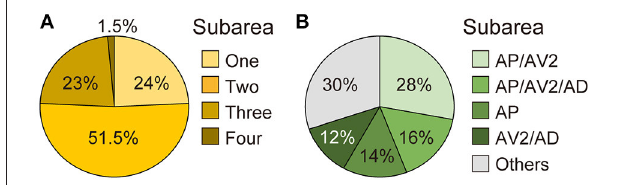
FIGURE 4 | Projection target of single JO-A neurons. (A) Percentage of single neurons that innervate one, two, three, or four subareas. (B) Major types of JO-A neurons.